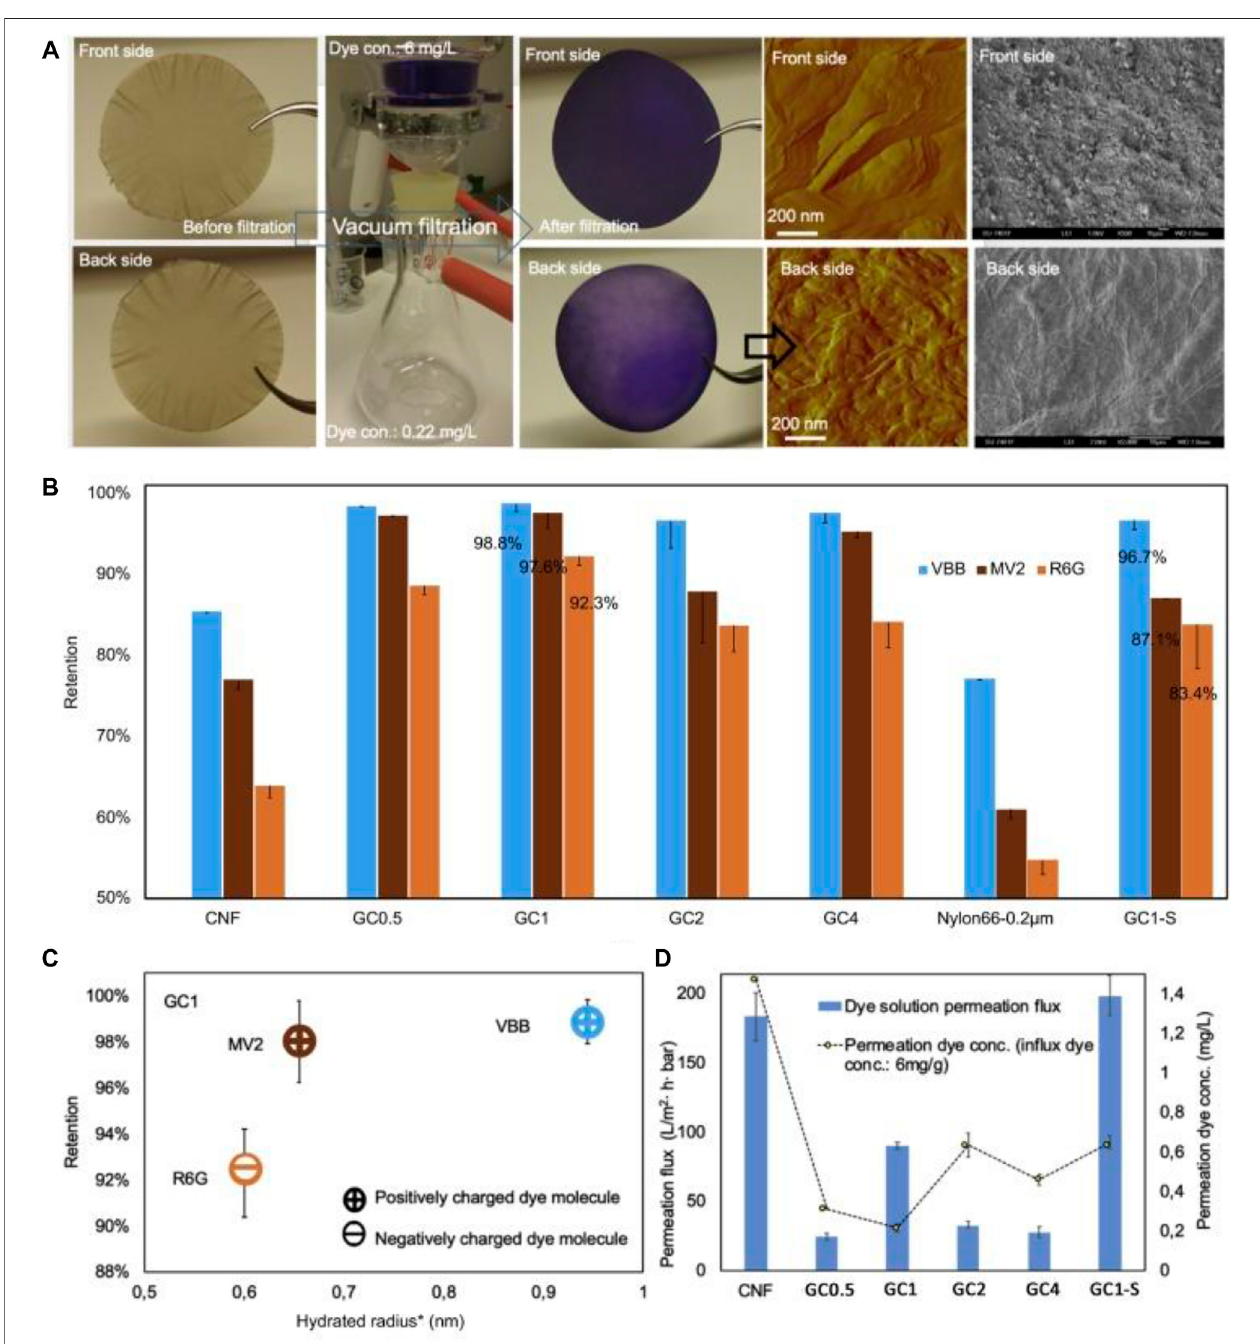
FIGURE 9 | Dye fi ltration performance, (A) Photograph and micrograph of GO-CNF1 membrane after dye fi ltration. (B) Retention of dye molecules by the membranes. (C) Retention performance ofGO-CNF1 membrane, as afunction of hydrated radius for the probe dye molecules with different charges; (D) permeation of dye solution through the membranes. Figure reprinted with permission from Ref. (Liu et al., 2019c). Copyrights belong to Elsevier (2019).